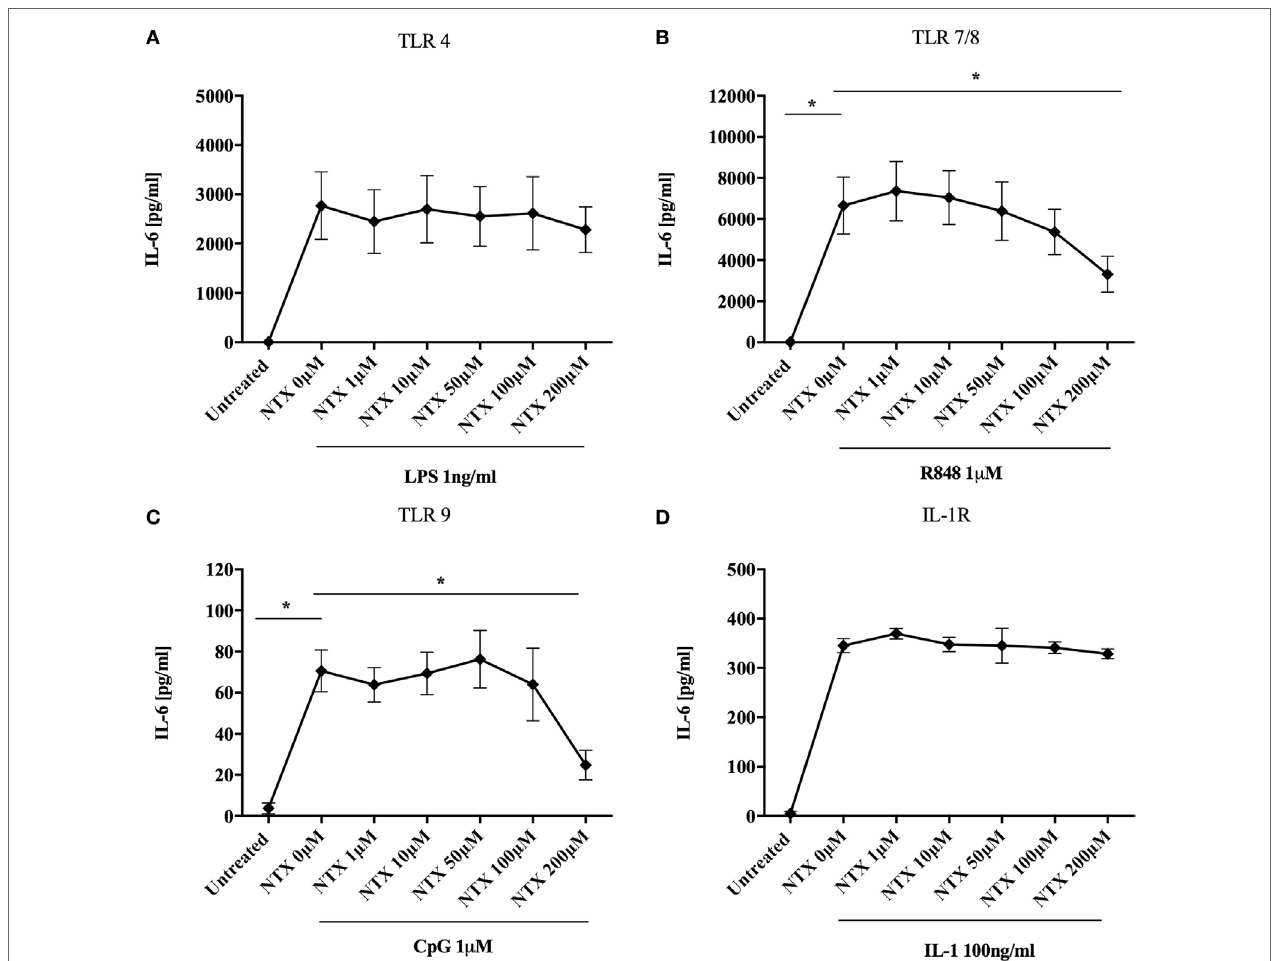
FigUre 1 | Naltrexone inhibits IL-6 production after toll-like receptor (TLR)7/8 and TLR9 stimulation but not after TLR4 or IL-1 stimulation. 1 × 10 6 peripheral blood mononuclear cells were incubated with (a) 1 ng/ml LPS (TLR4-L), (B) 1µM R848 (TLR7/8-L), (c) 1µM CpG (TLR9-L), (D) 100 ng/ml IL-1 (IL-1R) in the presence or absence of 1–200µM naltrexone for 24 h. Cell-free supernatants were collected and analyzed for IL-6 by ELISA. Data show the mean; SD values are shown and were analyzed using an one-way ANOVA and Tukey’s multiple comparison test ( n = 5 TLR ligand experiments and n = 3 IL-1). * p <